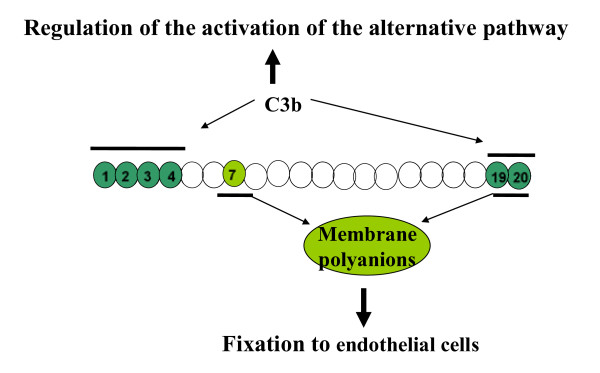
Factor H. Factor H is constituted by 20 short consensus repeats (SCR). The two binding sites for C3b are in SCR 1-4 and 19-20. The binding sites for polyanions of cell surface (vascular endothelium) are in SCR 7 and 19-20. SCR 1-4 are involved in the binding of CFH to circulating C3b i.e. the regulation of complement alternative pathway activation in the fluid phase. SCR 7 and 19-20 are involved in the binding of CFH to polyanionic surface-bound C3b i.e. the regulation of complement alternative pathway activation at the endothelial cell surface.